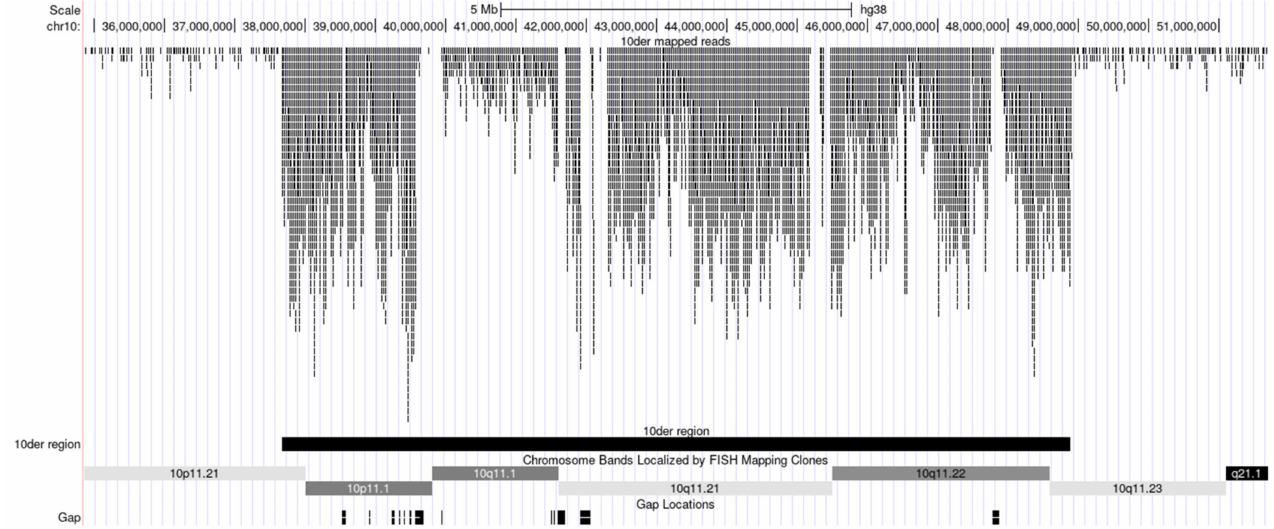
Figure 9. NGS read mapping for the microdissected sSMC on chromosome 10 of the hg38 reference genome. Only unique read mappings are